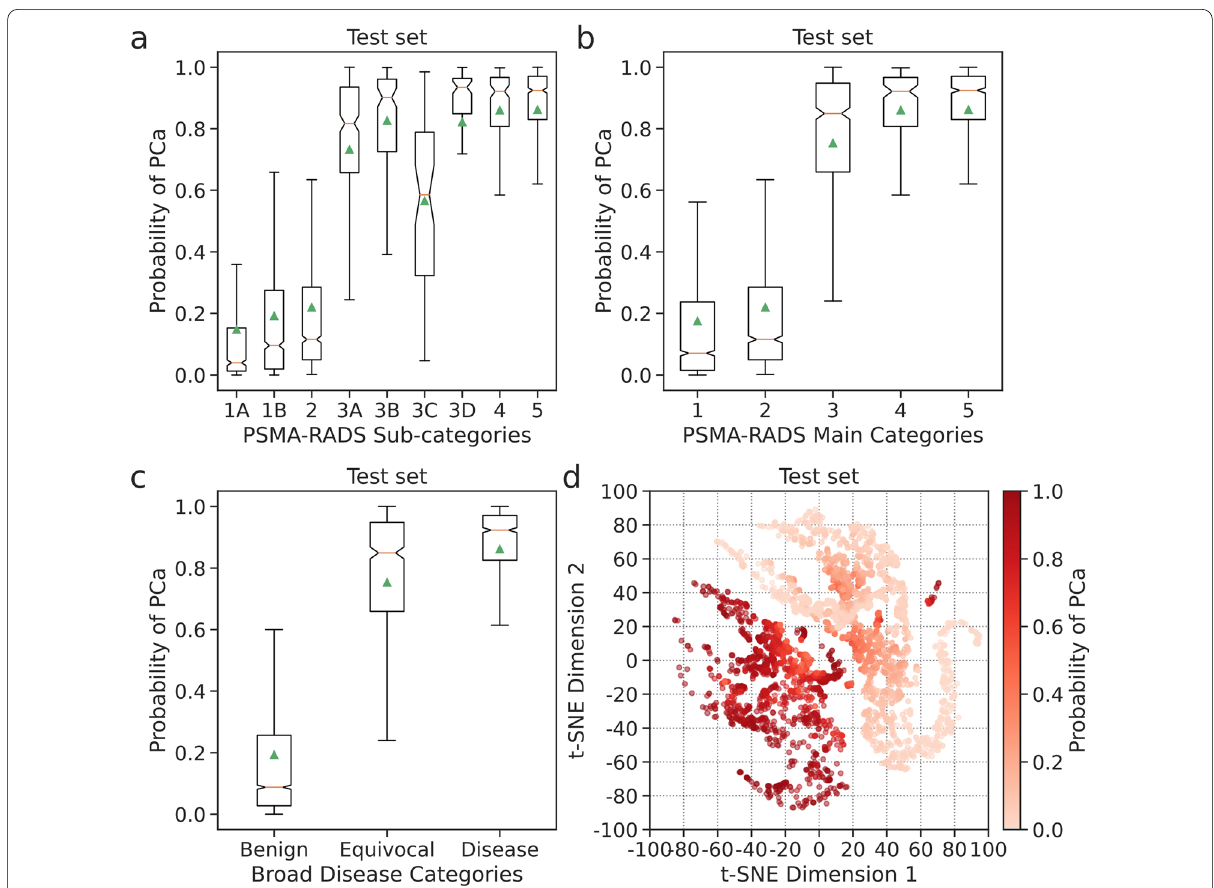
Fig. 6 Notched boxplots of probability scores according to each of the PSMA-RADS sub-categories ( a ), the main PSMA-RADS categories ( b ), and the broad disease categories ( c ) where the green triangles correspond to the mean and the horizontal lines correspond to the median. Probability scores that reflect the likelihood of PCa were depicted on a t-SNE scatter plot ( d